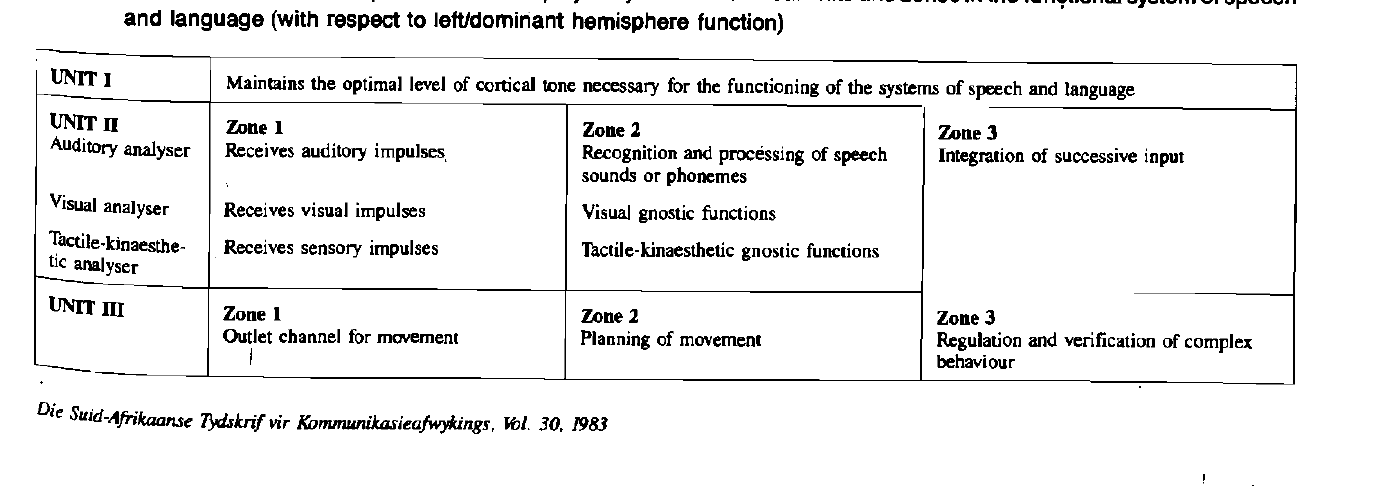
Table 1 An illustration of some aspects of the roles played by different cortical units and zones in the functional system of speech and language (with respect to left/dominant hemisphere function) UNIT I Maintains the optimal level of cortical tone necessary for the functioning of the systems of speech and language UNIT Π Auditory analyser Visual analyser Tactile-kinaesthe- tic